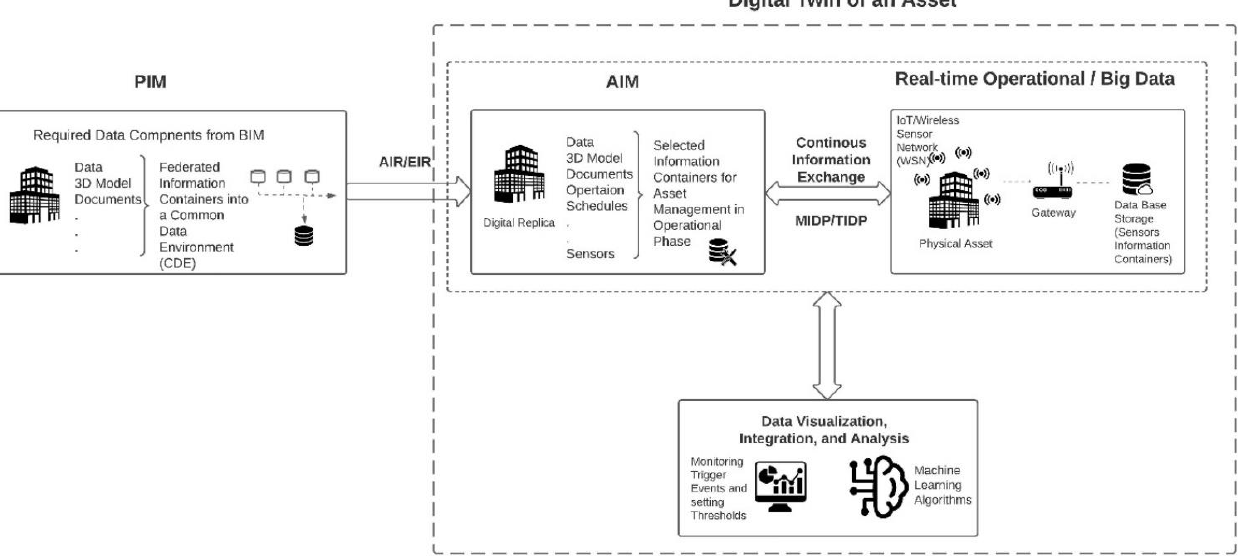
Figure 3. DT framework for construction assets based on BIM ISO 19650 standard specifications.